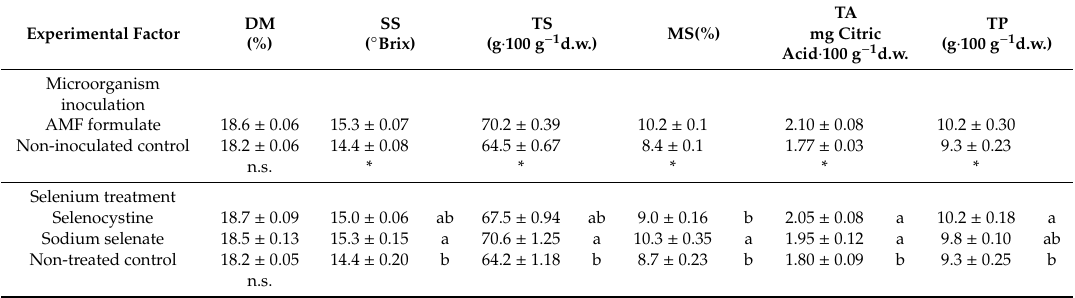
Table2. Shallotbulbqualityindicatorsasa ff ectedbymicroorganisminoculationandseleniumtreatment. Experimental